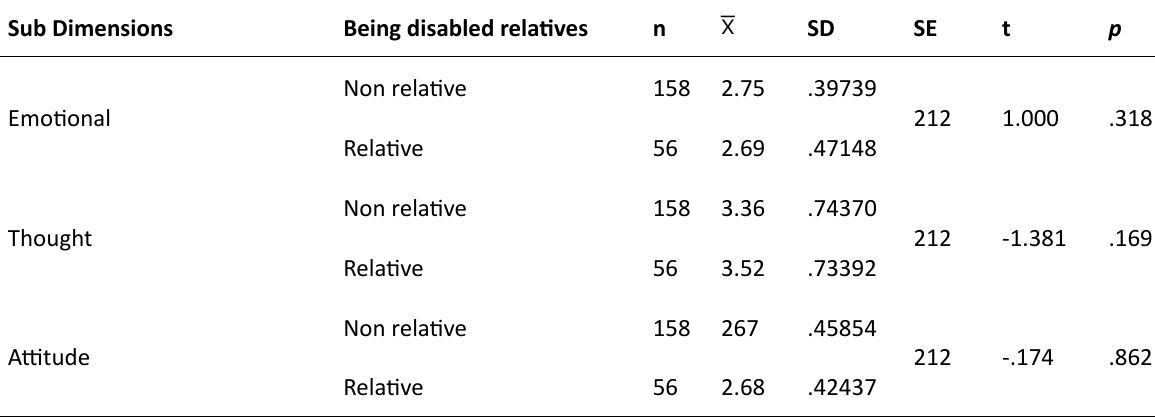
Table 2. Independent Sample T Test Results According to Status of Disabled Relatives